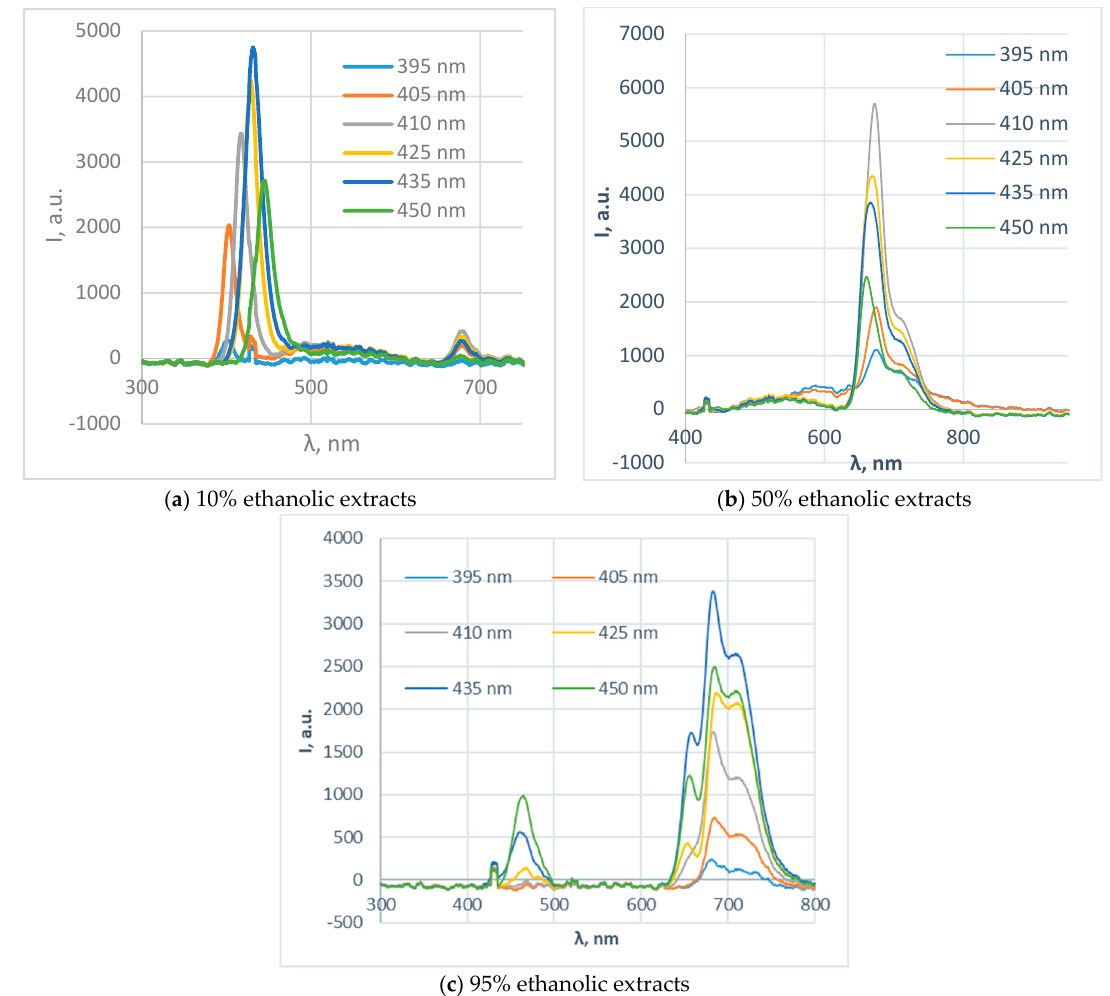
Figure 3. Fluorescence spectra in the visible region for water ethanol extracts from Sempervivum tectorum L.: ( a ) 10%; ( b ) 50%; ( c ) 95%.